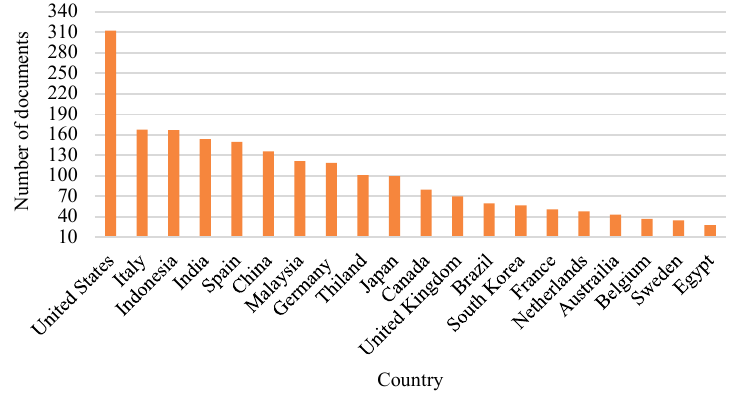
Fig. 2. Documents published per country.